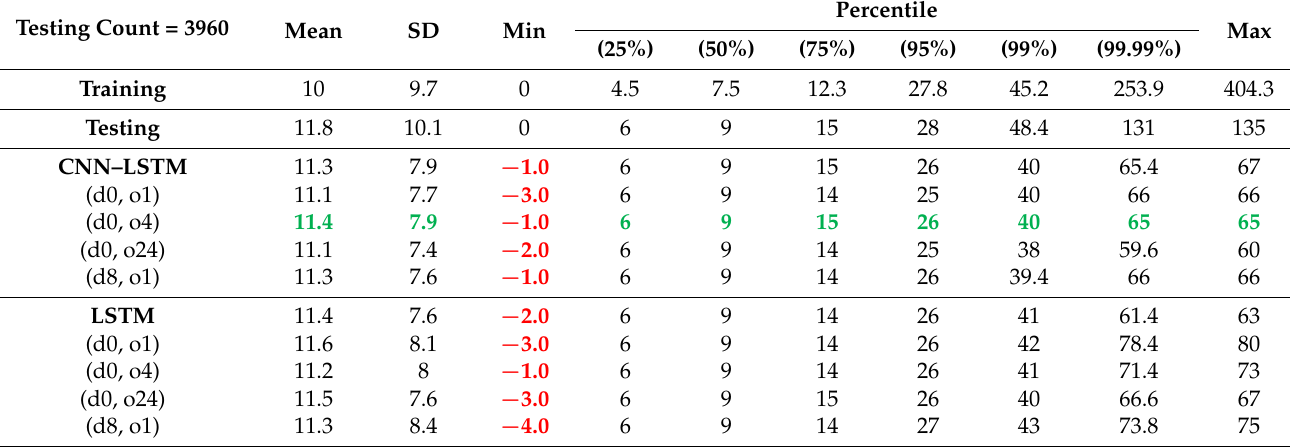
Table 10. Output statistics of CNN–LSTM and LSTM along with NARX vs. training and testing output for the seventh iteration for the Manchester